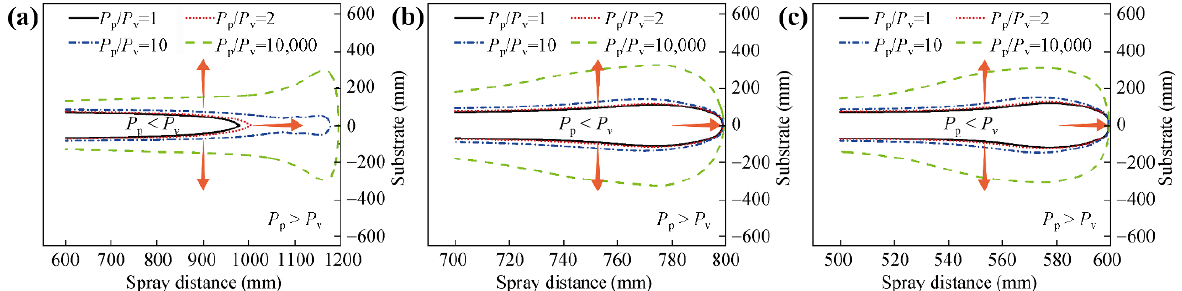
Fig. 75 Effects of spraying distances on boundary layer with spraying distance (SD): (a) 1200 mm, (b) 800 mm, and (c) 600 mm (the red arrows represent the increasing trend of supersaturation with a powder feed rate of 20 g·min − 1 ). Reproduced with permission from Ref. [413], © Elsevier B.V.